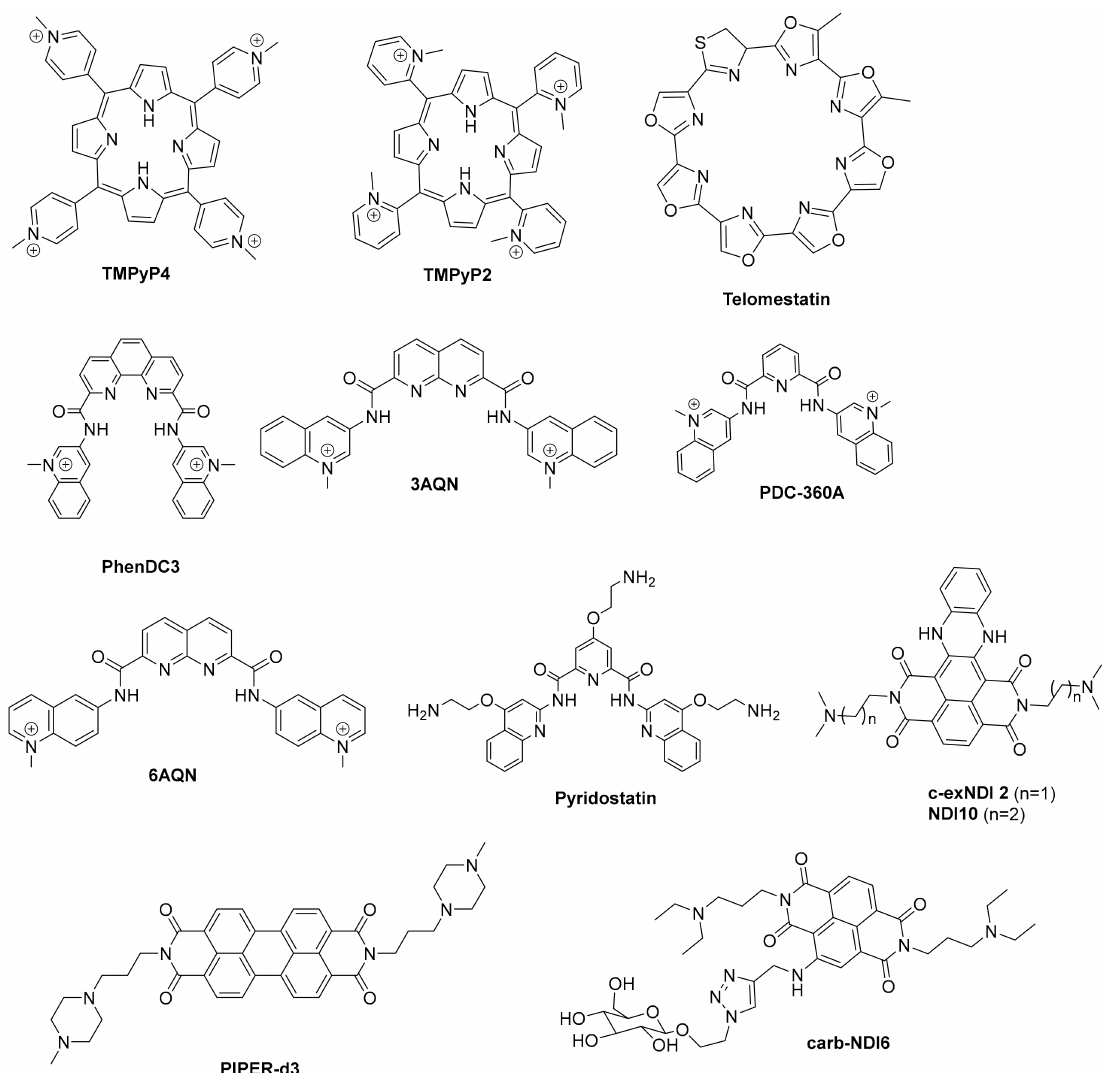
Figure 6. Structures of G4 ligands mentioned in Tables 2 and